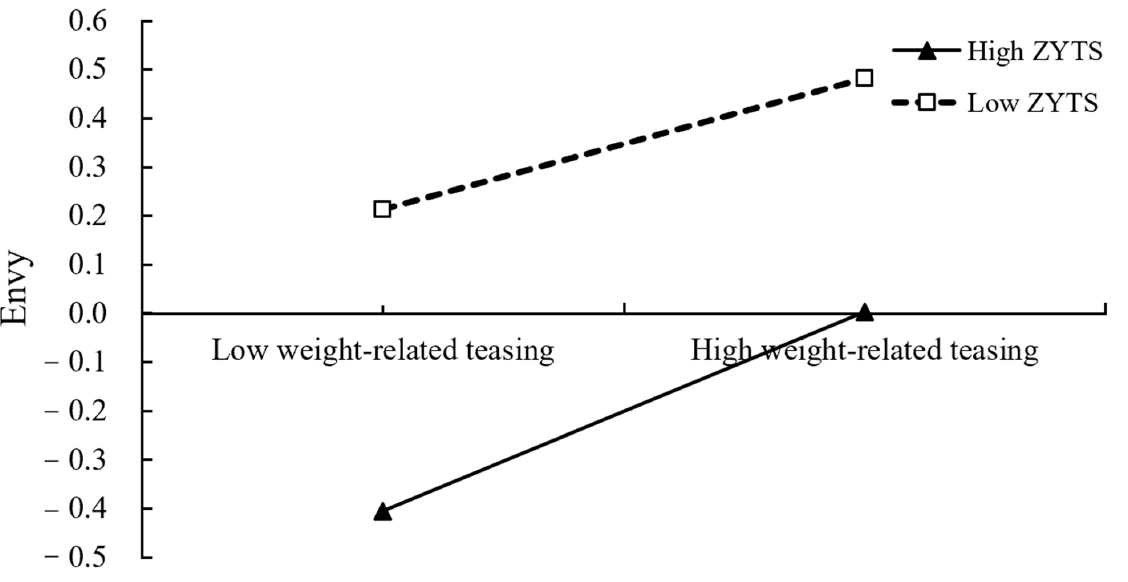
Figure 2. ZYTS as a moderator in the relationship between weight-related teasing and envy (ZYTS = the Zhong-Yong thinking style).